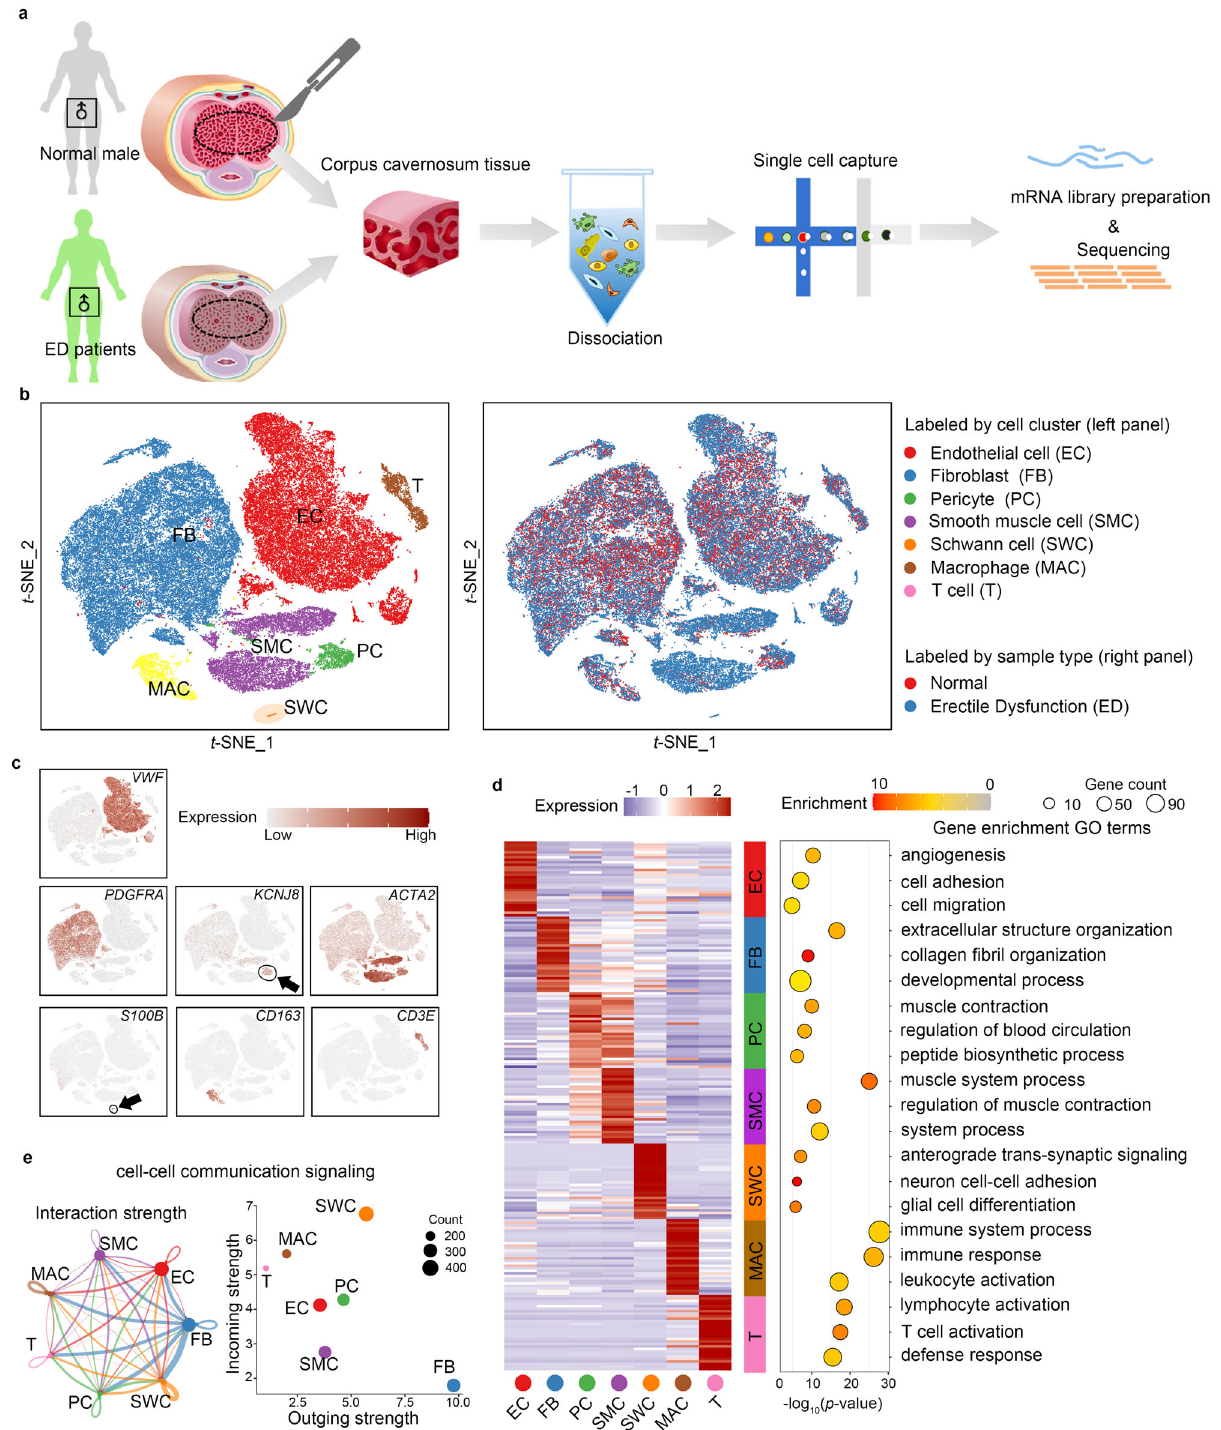
Fig. 1 | Global expression pro fi ling of human corpus cavernosum cells in normal male and ED patients by single-cell RNA-seq. a Schematic illustration of the experimental work fl ow in this study. b t-distributed stochastic neighbour embedding (tSNE) plots of all corpus cavernosum cells from eight donors (three normal males and fi ve ED patients). Cells are coloured according to their types (left panel) or state (right panel; red=Normal, blue=Erectile dysfunction). c Expression patterns of the following marker genes for each cluster are projected on the tSNE plot of allCCcells: VWF (endothelialcells), PDGFRA ( fi broblast), KCNJ8 (pricytes), ACTA2 (smooth muscle cells), S100B (Schwann cells), CD163 (macro- phages) and CD3E (T cells). A gradient of light grey to dark red indicates low to high expression levels. d Heatmap of the top 30 DEGs in each major cluster (left